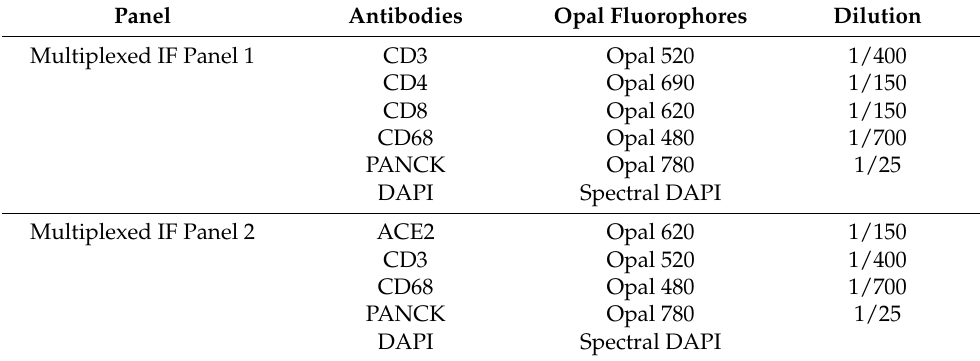
Table 2. Composition of antibodies used in the multiplexed immunofluorescence panels. Panel Antibodies Opal Fluorophores Dilution Multiplexed IF Panel 1 CD3 Opal